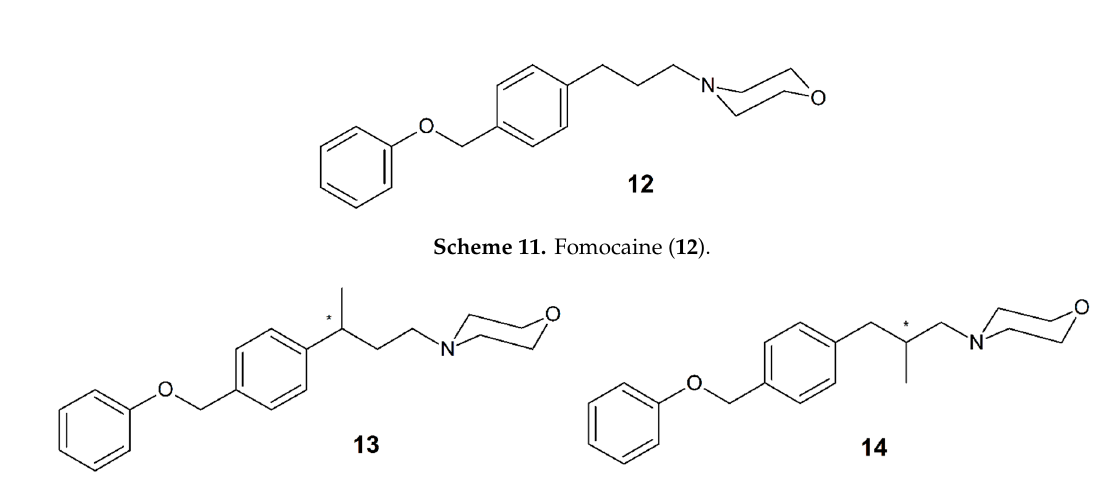
8 of 19 3.10. Pentacaine Pentacaine, trans -(±)-2-(pyrrolidine-1-yl)cyclohexyl(3-pentyloxyphenyl)carbamate ( 11 , Scheme 10), also known as trapencaine, exhibits besides local anesthetic efficacy gastroprotective and antiulcerative activities [61–63]. On the rat models used, the antiulcer effect was more pronounced in the case of the (+)- trans enantiomer than in the (+)- cis enantiomer. Scheme 10. Pentacaine (11). The effects of (±)- trans -2-(pyrrolidin-1-yl)cyclohexylester and its (+)- trans and ( − )- trans enantiomers, and (±)- cis -2-(pyrrolidin-1-yl)cyclohexylester and its (+)- cis and ( − )- cis enantiomers on length and number of gastric lesions induced by indomethacin and by 96% ethanol in rats were studied. With indomethacin the differences between (±)- trans -2-(pyrrolidin-1-yl)cyclohexylester and its (+)- trans and ( − )- trans enantiomers were not significant. However, the best protective effect (around 80%) was achieved after pretreatment with the (+)- trans isomer. The least effective drug was ( − )- trans -enantiomer. Similar results were obtained for lesion number. In ethanol-induced injury the greatest protective effect was observed after pretreatment with (+)- trans -enantiomer. Activities of the cis isomers were only of minor significance in the indomethacin model of gastric injury. Both the lesion length and lesion number were greater in comparison with control values. Pretreatment with ( − )- cis enantiomer even increased the damage. The differences between (+)- cis and ( − )- cis enantiomers were also insignificant. In the indomethacin model the antiulcer effect was higher with the (+)- trans enantiomer when compared with the (+)- cis enantiomer. [64] The absolute configuration of the stereoisomers has not been reported. Only data on the differences in antiulcer activities of the discrete enantiomers are available so far. 3.11. Fomocaine Based on changes in the activity of anilide-group stereoisomers, studies were conducted with stereoisomers of fomocaine derivatives from the base ether family. Fomocaine 4-[3-(4- (phenoxymethyl)phenyl)propyl]morpholine ( 12 , Scheme 11), does not contain a stereocenter, but its two chiral derivatives (+)-O/G5 ( 13 ) and (-)-O/G3 ( 14 ) (depicted in Scheme 12) were compared with fomocaine and procaine. Surface local anesthetic activity in both isomers was lower than in procaine. (+)-O/G3 and ( − )-O/G3 exhibited higher activity than fomocaine, but without practical application.